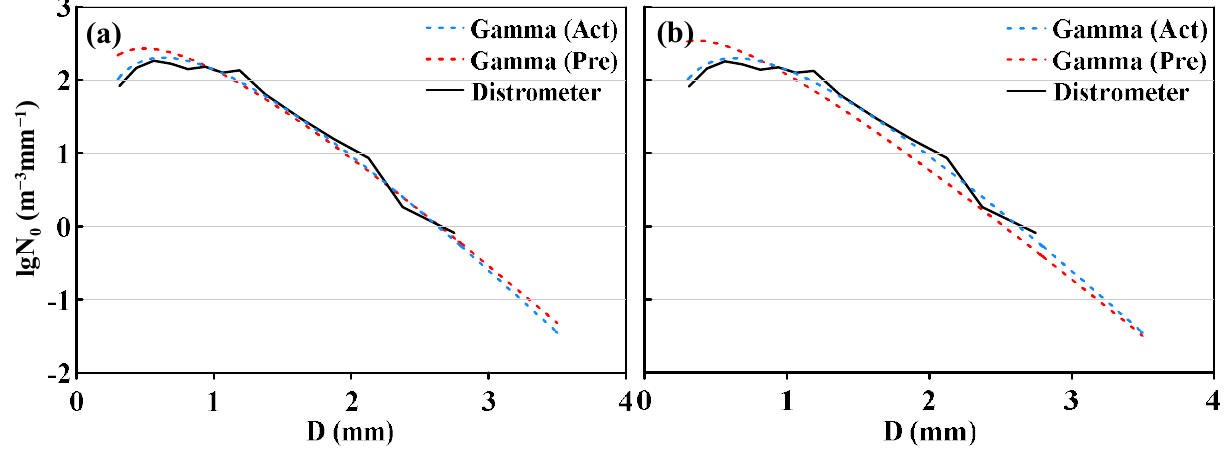
Figure 14. The DSDs of measurement (black solid line), Gamma fitting (blue dotted line), and model prediction (red dotted line, ( a ) 12-min and ( b ) 30-min prediction) at the 594th min of this mixed convective-stratiform cloud precipitation case.